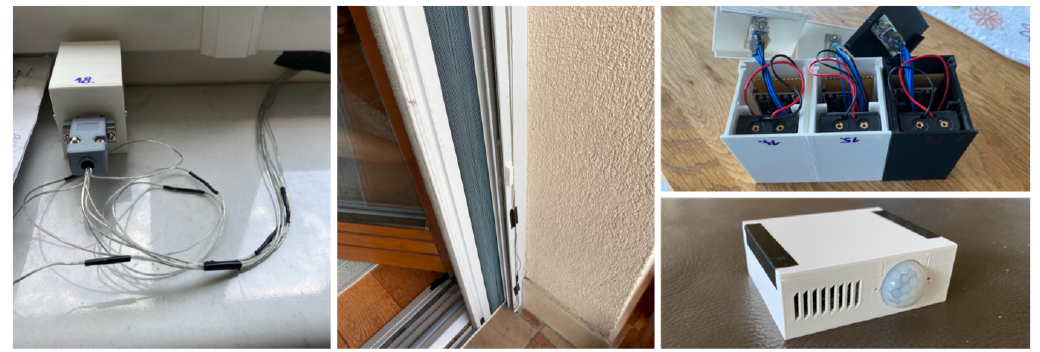
Figure 2. Monitoring sensors in the apartment (window opening, shading, motion